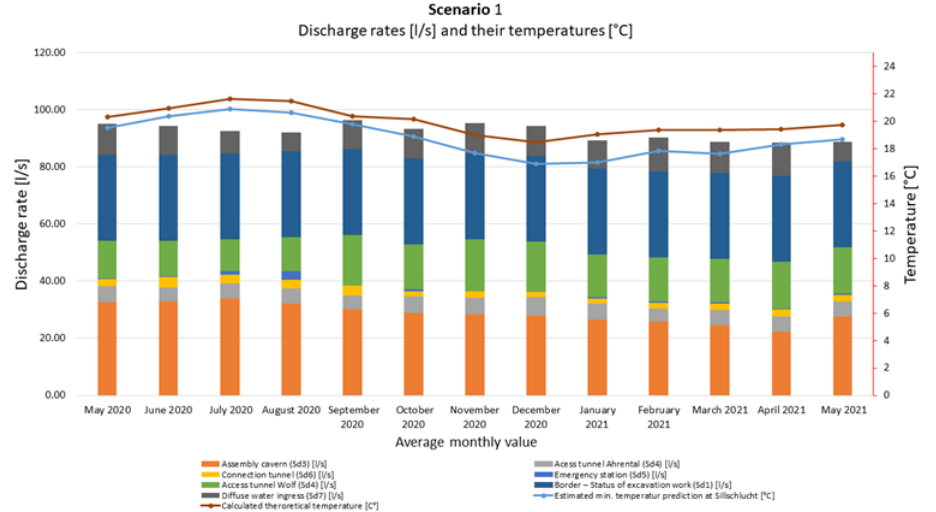
Figure 7. Discharge rates [L/s] (primary axis) in connection with the by the Richmann’s mixing rule calculated theoretical (brown line) and the min. theoretical temperature (blue line) temperature [°C] at the nothern portal of Innsbruck, Sill Gorge, during operation for Scenario 1.